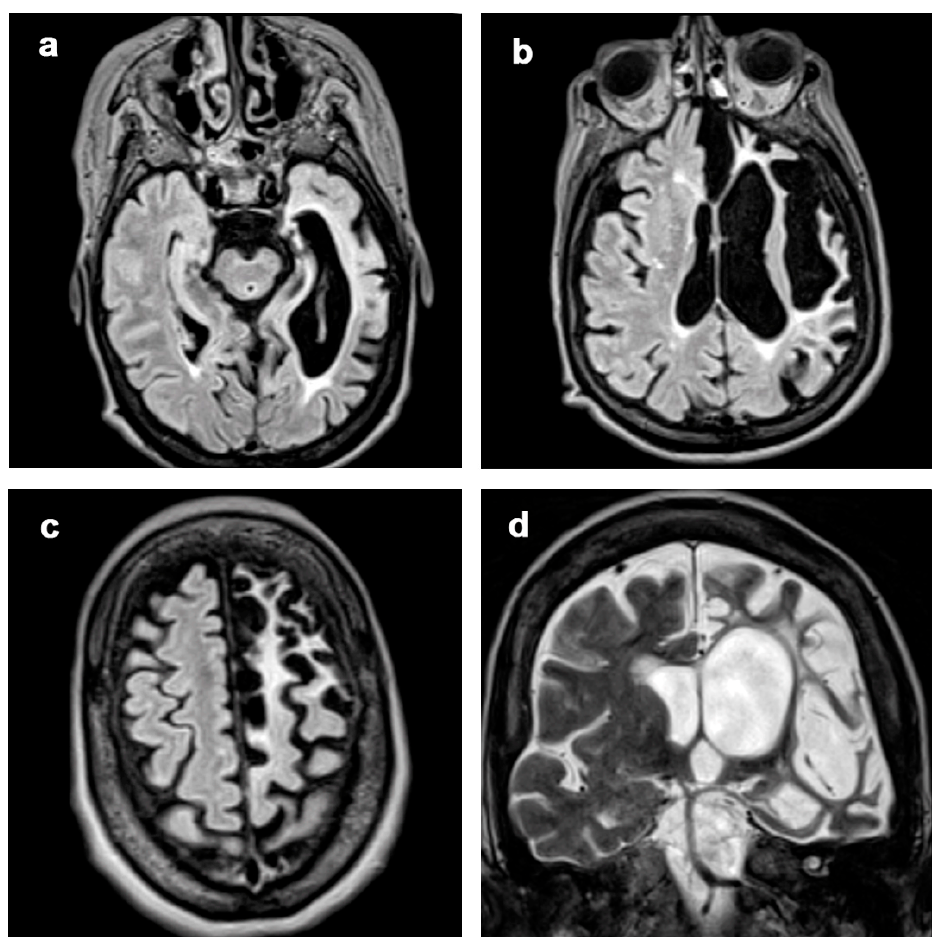
Figure 7. Patient 13, with stable atrophy changes during 12 years of MRI controls. Axial FLAIR images ( a – c ) and coronal T2-weighted image ( d ) at a single timepoint, showing frontal, insular and temporal atrophy with SI involving subcortical WM and cortical GM. The patient has a 25 years of disease duration with clinical onset with focal deficits, seizures and cognitive disorders; at last follow-up, EPC and behavioral disorders are present.